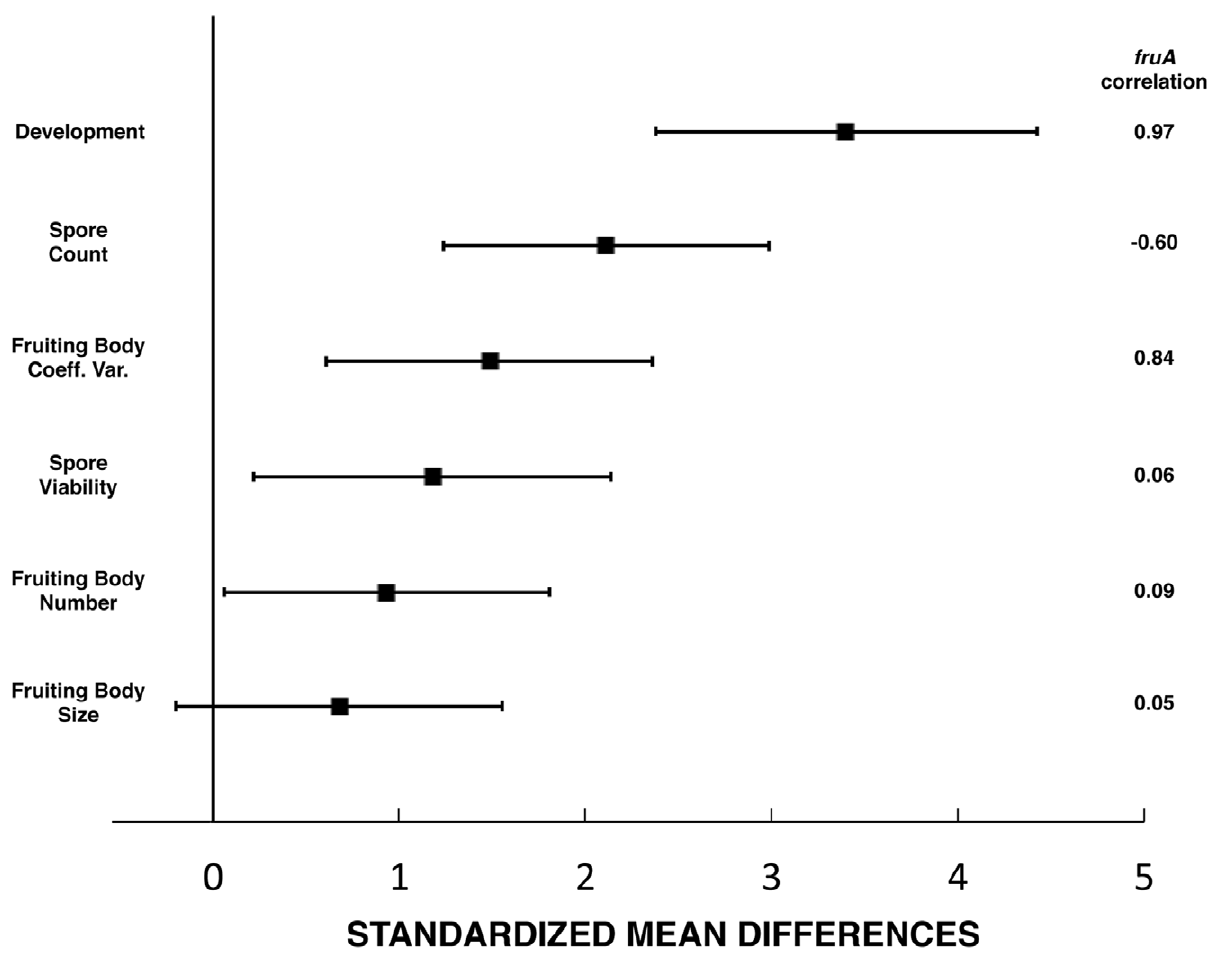
Figure 5. Standardized mean difference among mutants and parental strains. Error bars are 95% confidence intervals (CI) for the observed phenotypic variation. Statistical differences between parental strain and mutants are supported by exclusion of ‘0 9 within the confidence intervals. The right-hand column shows correlation coefficients for differences among the mutant strains with fruA expression.